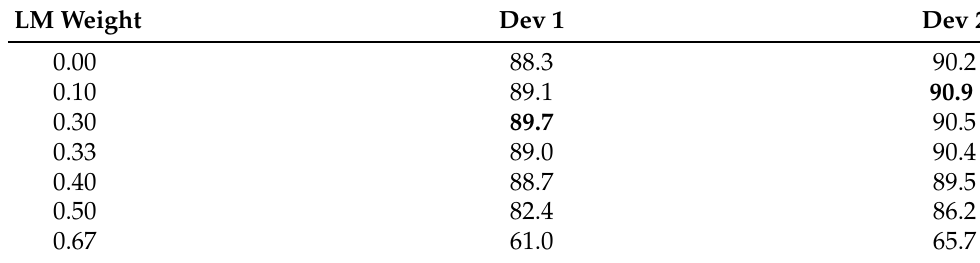
Table 4. Results with different dev